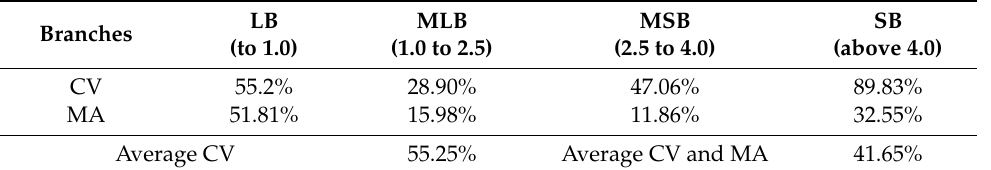
Table 5. Multi-criteria analysis of liquidation processes costs “costs